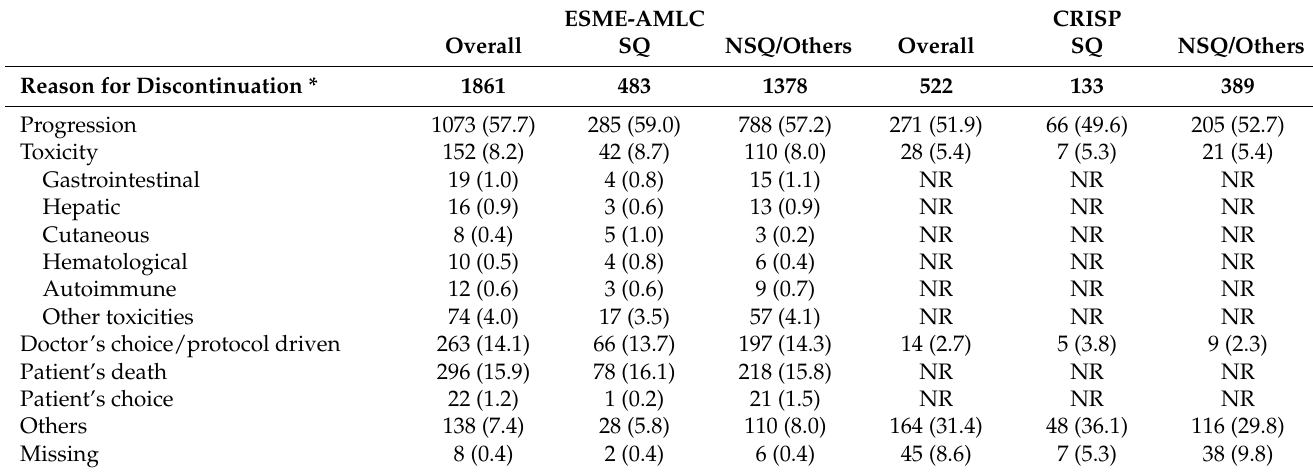
Table 3. Reasons for discontinuation of nivolumab in patients treated in 2L+ in ESME-AMLC and CRISP, overall and by